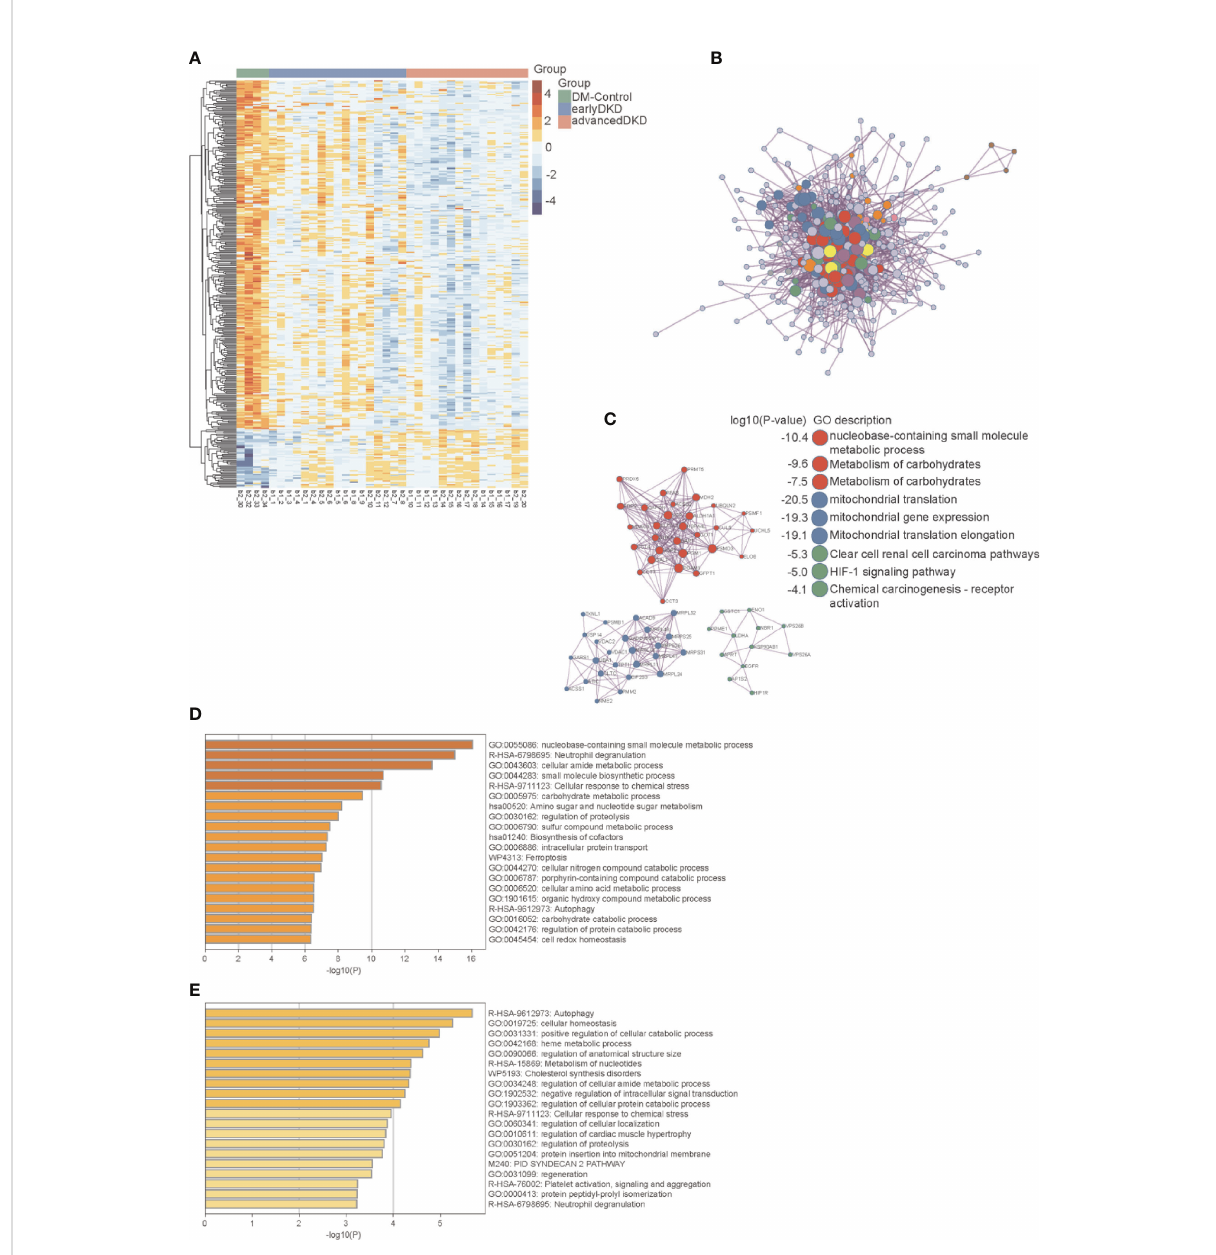
FIGURE 4 Protein interaction network and pathway enrichment analyses. (A) Heatmap showing the expression of 363 differentially expressed proteins in the DM control, early DKD, and advanced DKD groups. (B) Network interactions among major differentially expressed proteins. (C) MCODE components identi fi ed in the protein lists. (D) Pathways enriched in differentially expressed proteins using a cutoff value of p<0.05. (E) Pathways enriched in differentially expressed proteins using a cutoff value of p<0.01. The p-values were calculated and adjusted by one-way ANOVA followed by Benjamini & Hochberg correction. DM, diabetes mellitus; DKD, diabetic kidney disease; MCODE, Molecular Complex